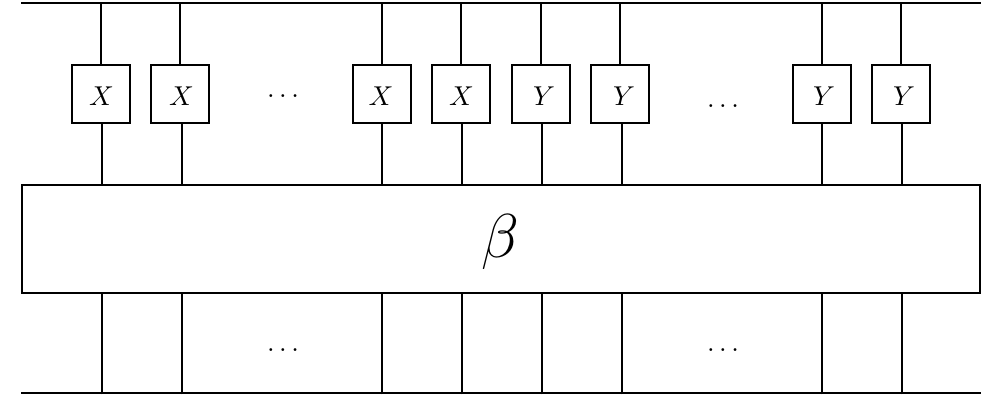
Figure 4 . Diagrammatic representation of the U( N ) contraction. Each vertical line represents an index, while the horizontal lines at the top and bottom indicate that we have traced over these